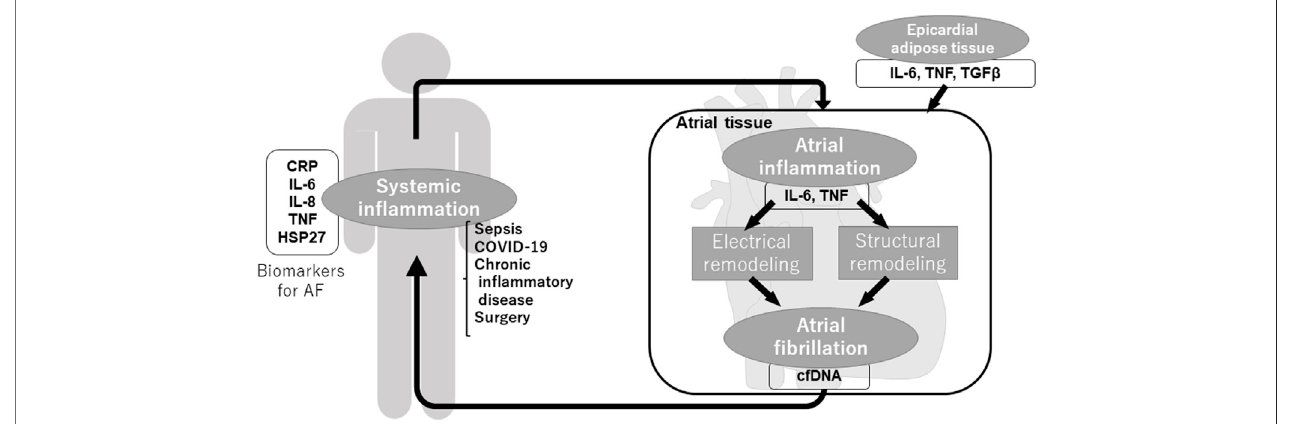
FIGURE 1 | In fl ammation and atrial fi